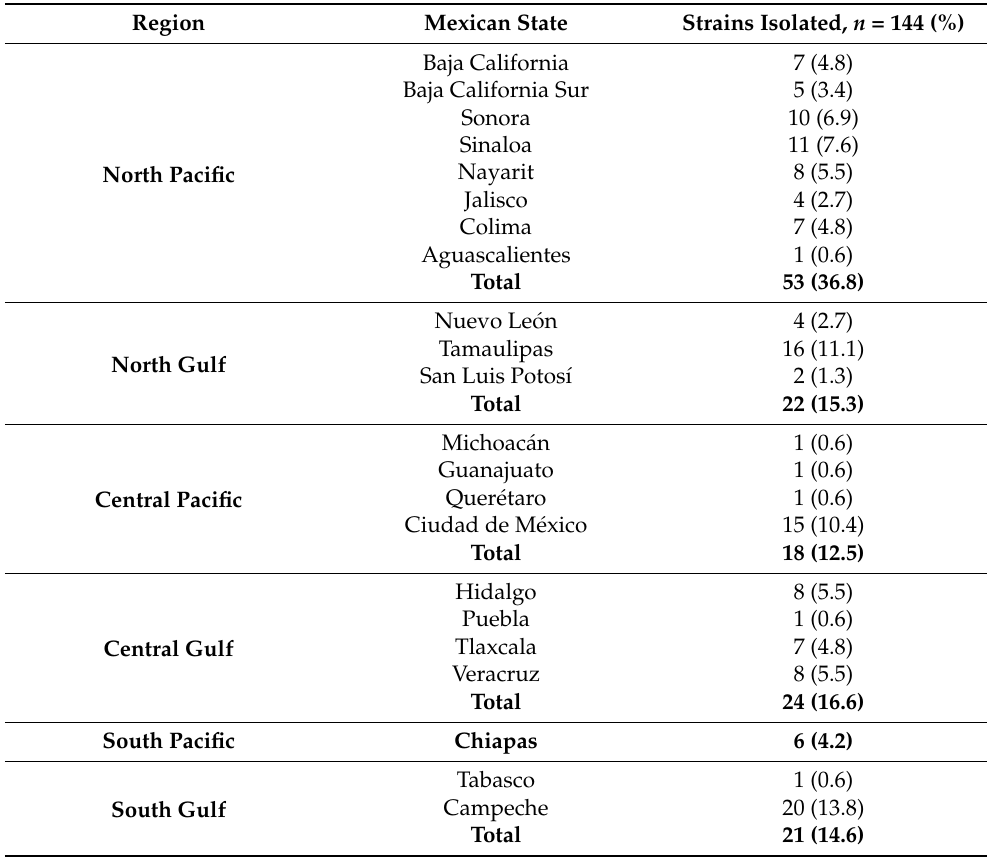
Table 1. Geographical distributions of Vibrio parahaemolyticus isolates in Mexican States from 2004 to 2011. Region Mexican State Strains Isolated, n = 144